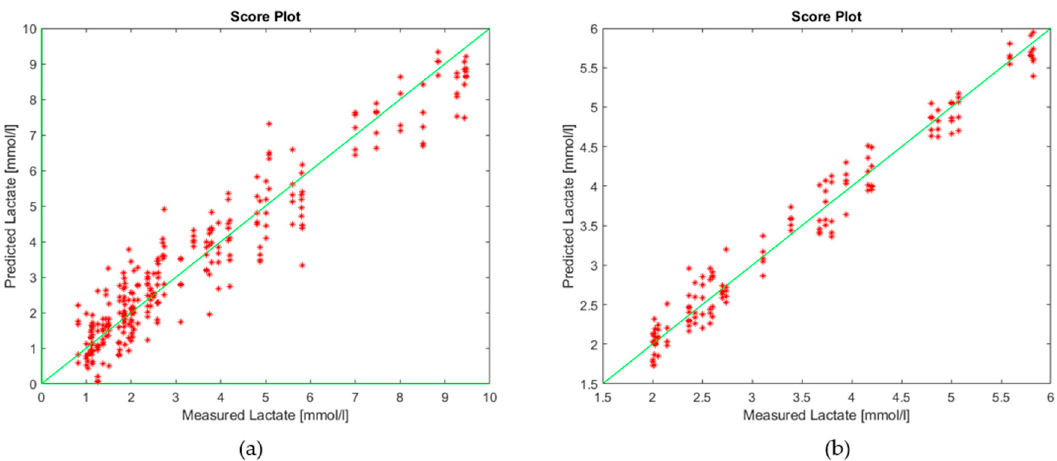
Figure 4. Score plot of ( a ) lactate in the range of 0–10 mmol / L; ( b ) lactate in the range of 2–6 mmol / L. Table 1. Model parameters obtained from saliva analysis.